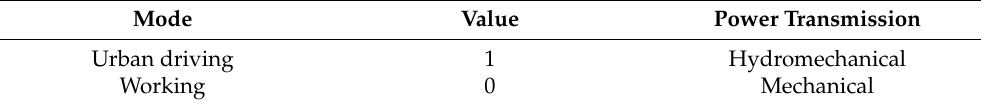
Table 4. Control signal of the operating mode.